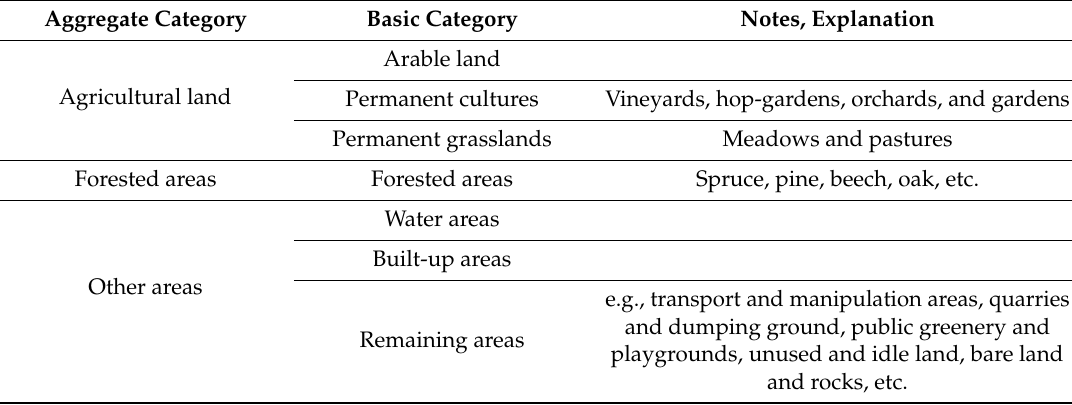
Table 1. Land use classification in the land use / land cover changes (LUCC) Czechia Database. Aggregate Category